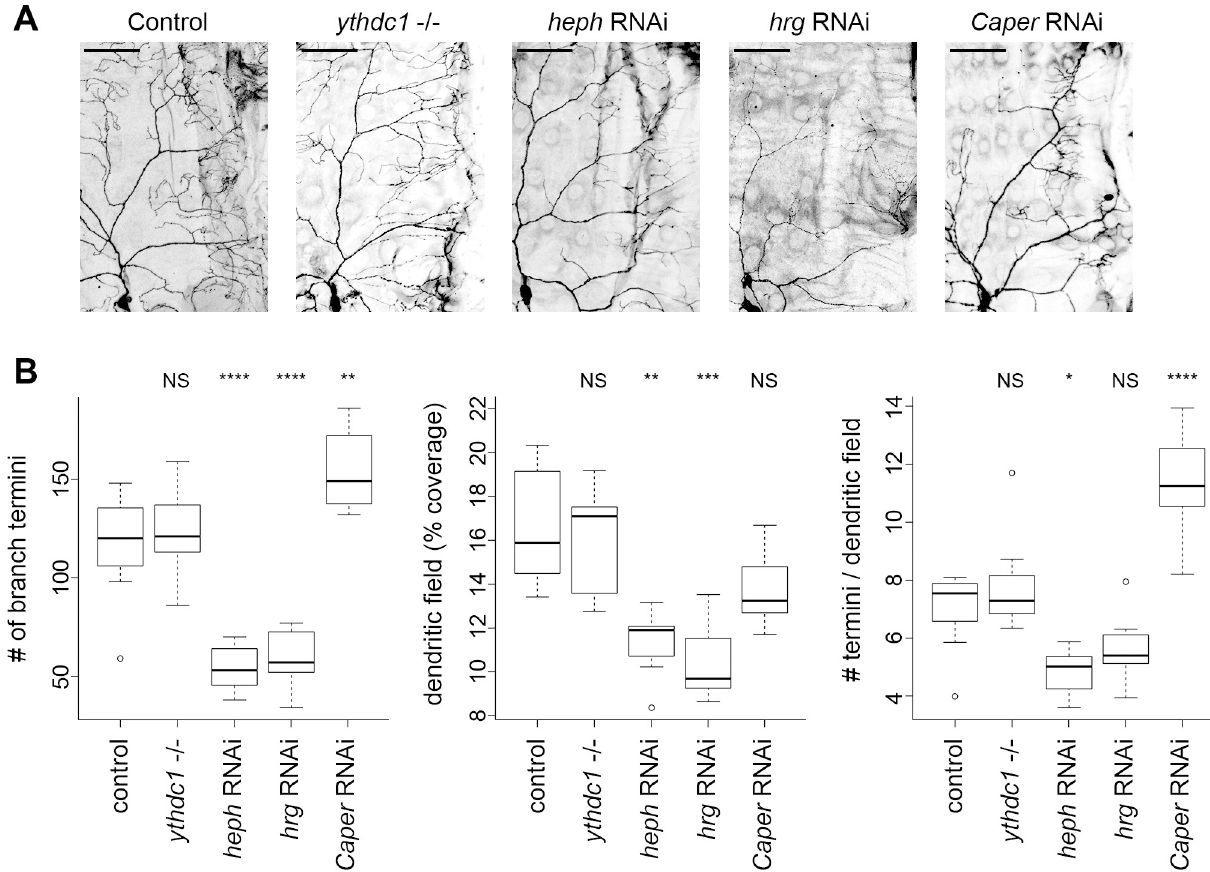
Fig 4. Identification of novel regulators of md neuron dendrite arborization. A. Dendrite arborization in control and mutant class IV ddaC neurons. A representative image is shown for each genotype. The same region was analyzed in all cases, with the cell body positioned at lower left. Larva anterior is to the left and dorsal is at the top. Scale bar = 50 μ m. B. Quantification of dendrite arborization. Within the window applied to all neurons (as shown in panel A), the number of branch termini were counted and the total dendrite length was traced and quantified (pixels) then divided by the total pixels of the window to calculate the dendritic field (% coverage). The number of termini per neuron was divided by the dendritic field % coverage to calculate # termini / dendritic field. Sample sizes: control n = 9, ythdc1-/- n = 9, heph RNAi n = 8, hrg RNAi n = 8, Caper RNAi n = 8. Data were analyzed using ANOVA with Tukey HSD post-test. P-value code: ���� � 0.0001, ��� � 0.001, �� � 0.01, � � 0.05.